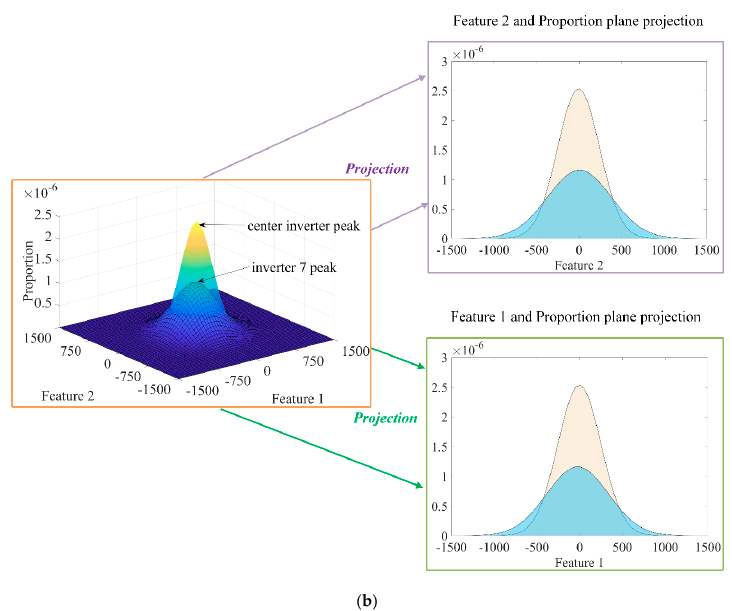
Figure 12. Feature distribution projections: ( a ) inverter 7 in January 2018; ( b ) inverter 7 in April